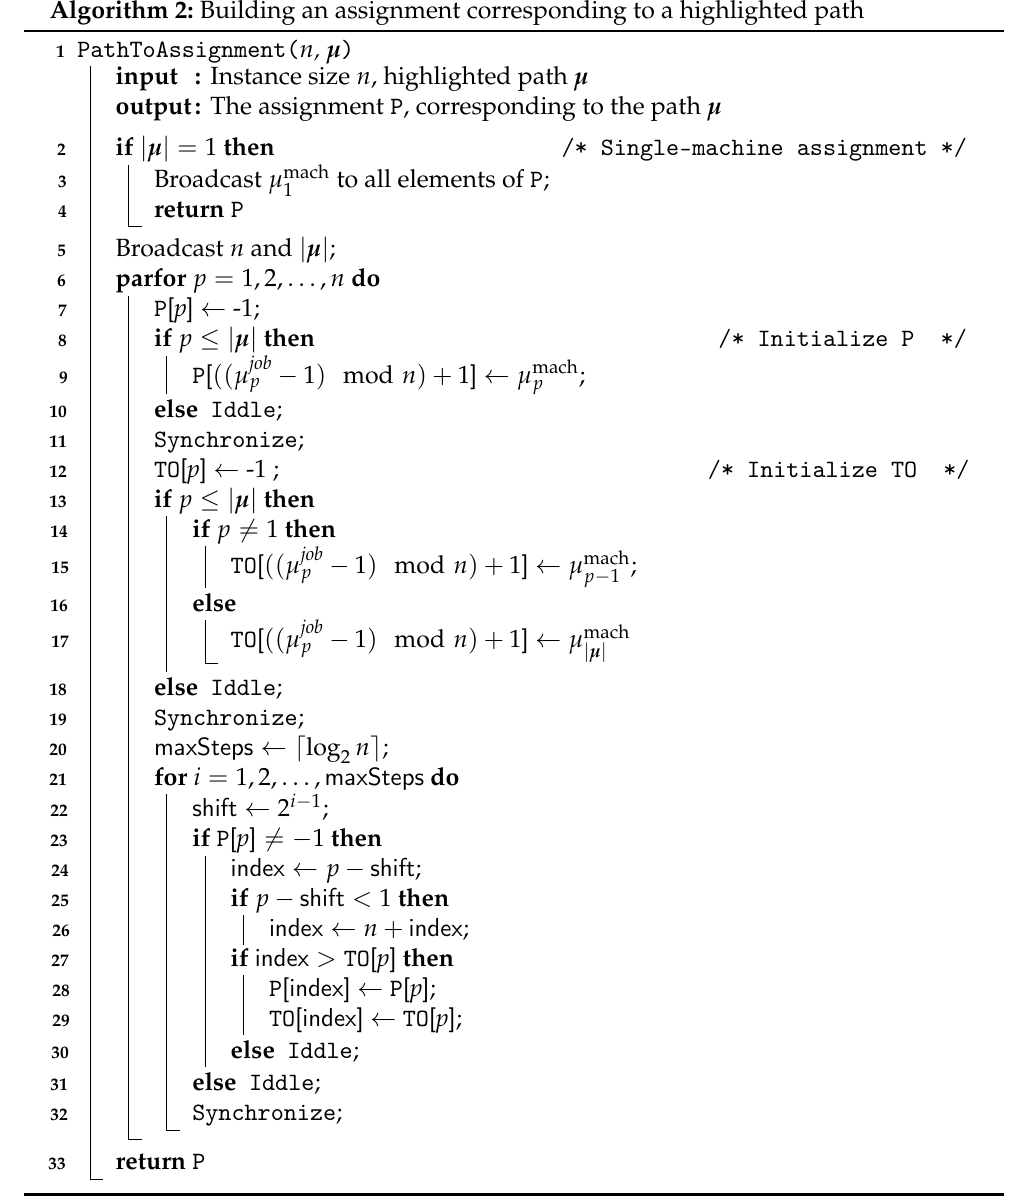
Algorithm 2: Building an assignment corresponding to a highlighted